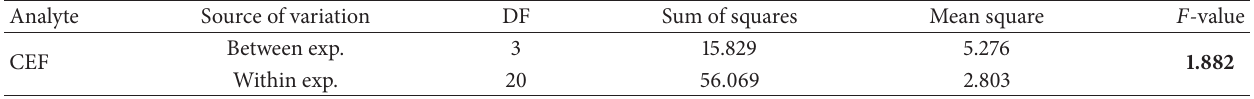
Table 5: One-way ANOVA parameters for the different proposed models used for the determination of CEF in Cefobid Vial. Analyte